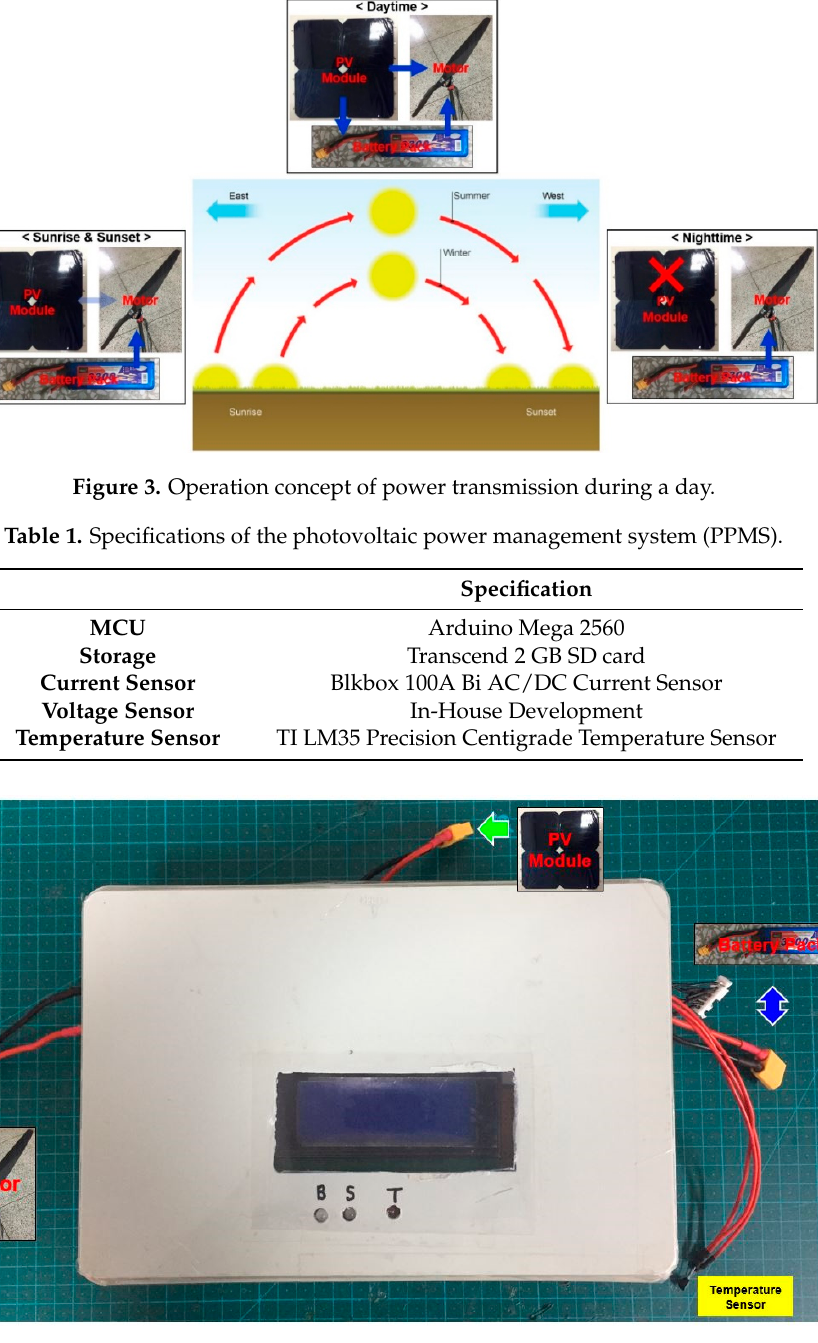
Figure 4. The hardware of the PPMS.